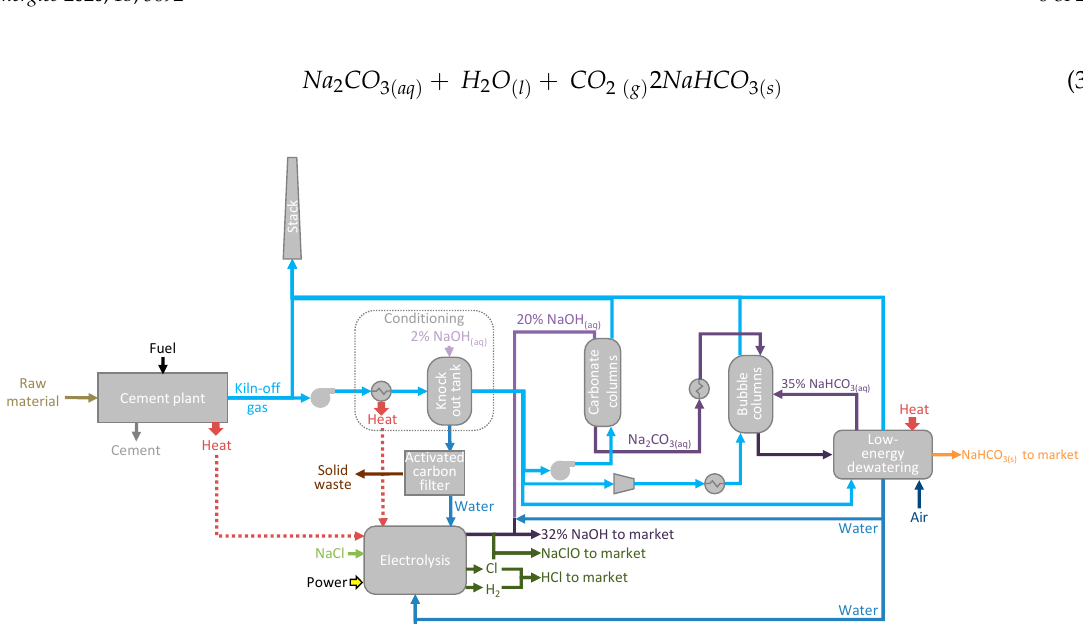
Figure 4. Simplified diagram flow of the SkyMine ® process integrated in San Antonio cement plant (adapted from [23,24]).